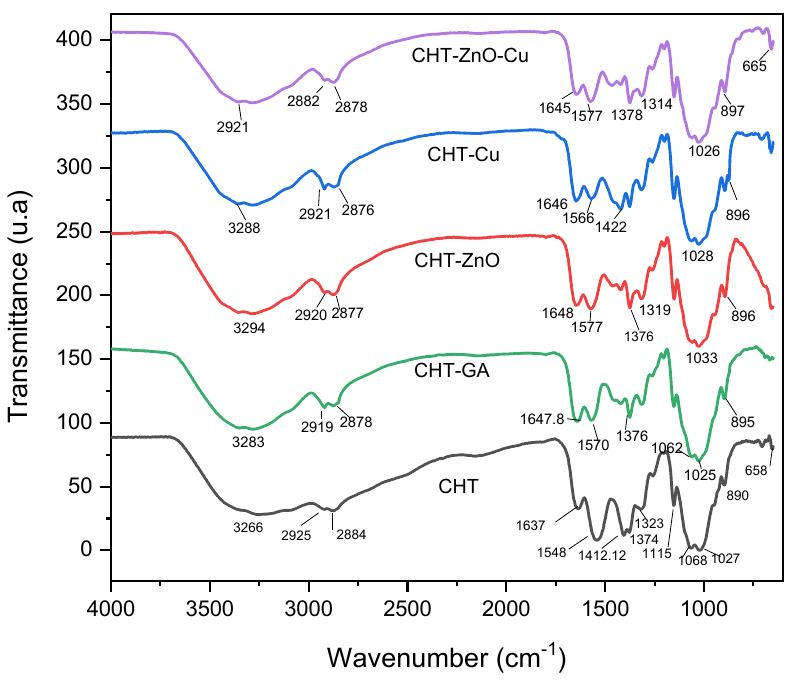
Figure 1. FTIR spectra of CHT, CHT/GA, CHT/Zn ‐ O, CHT/Cu, CHT/Zn ‐ O/Cu.